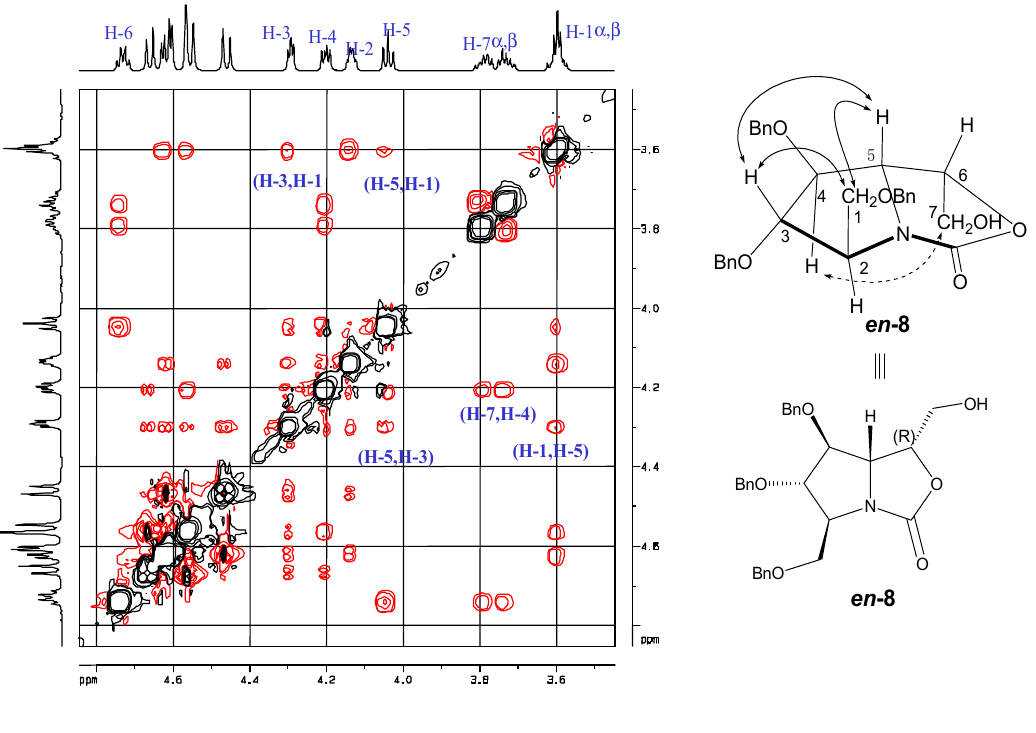
Figure 3. Stereochemistry elucidation of en- 8 by